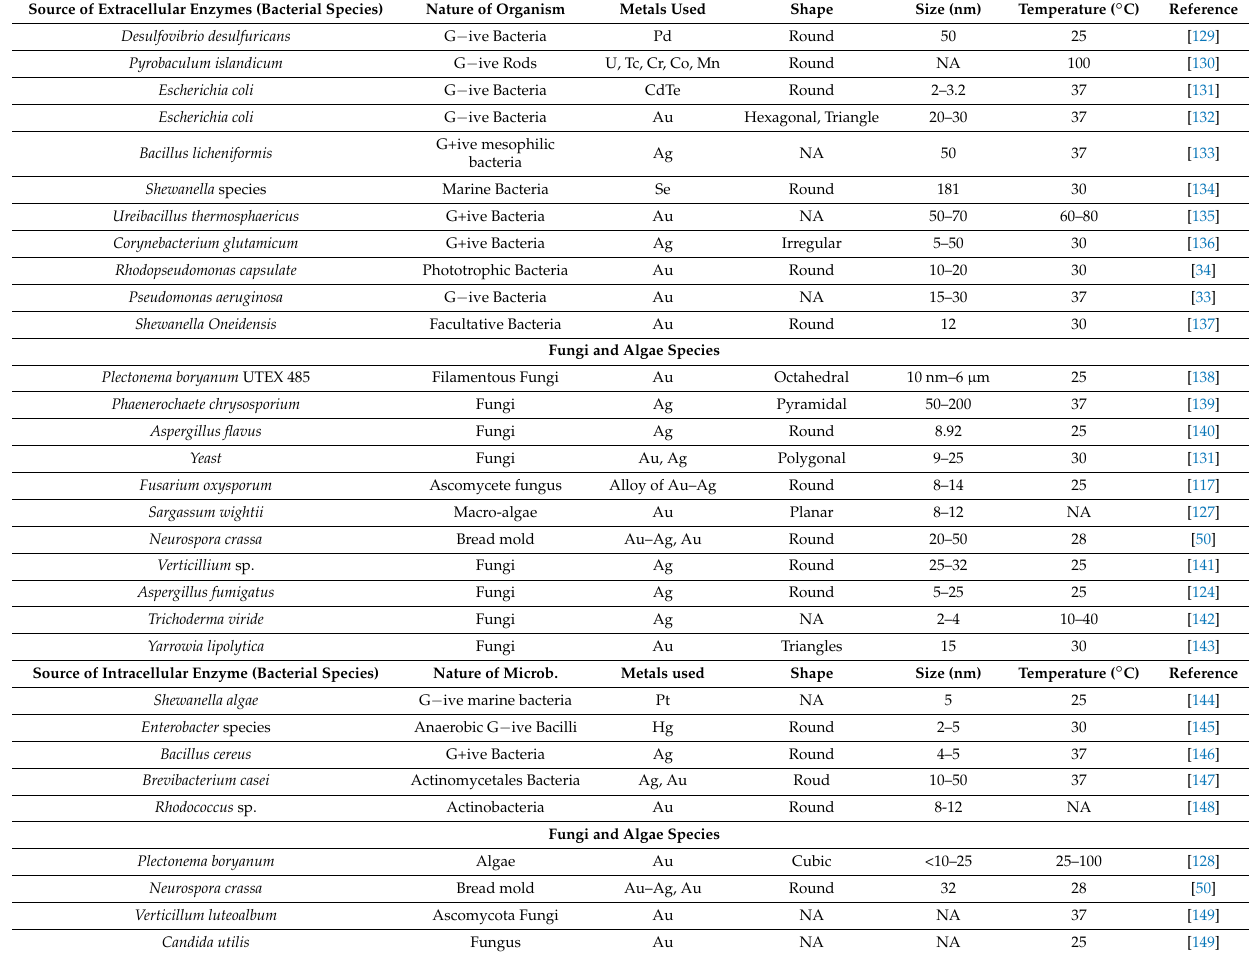
Table 2. List of extracellular and intracellular bioreducing microbial enzymes and resulting nanoparticles. Source of Extracellular Enzymes (Bacterial Species)